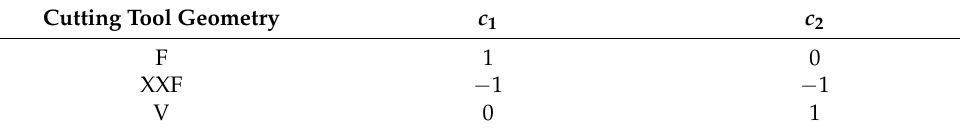
Table 1. Contrast matrix for the cutting tool